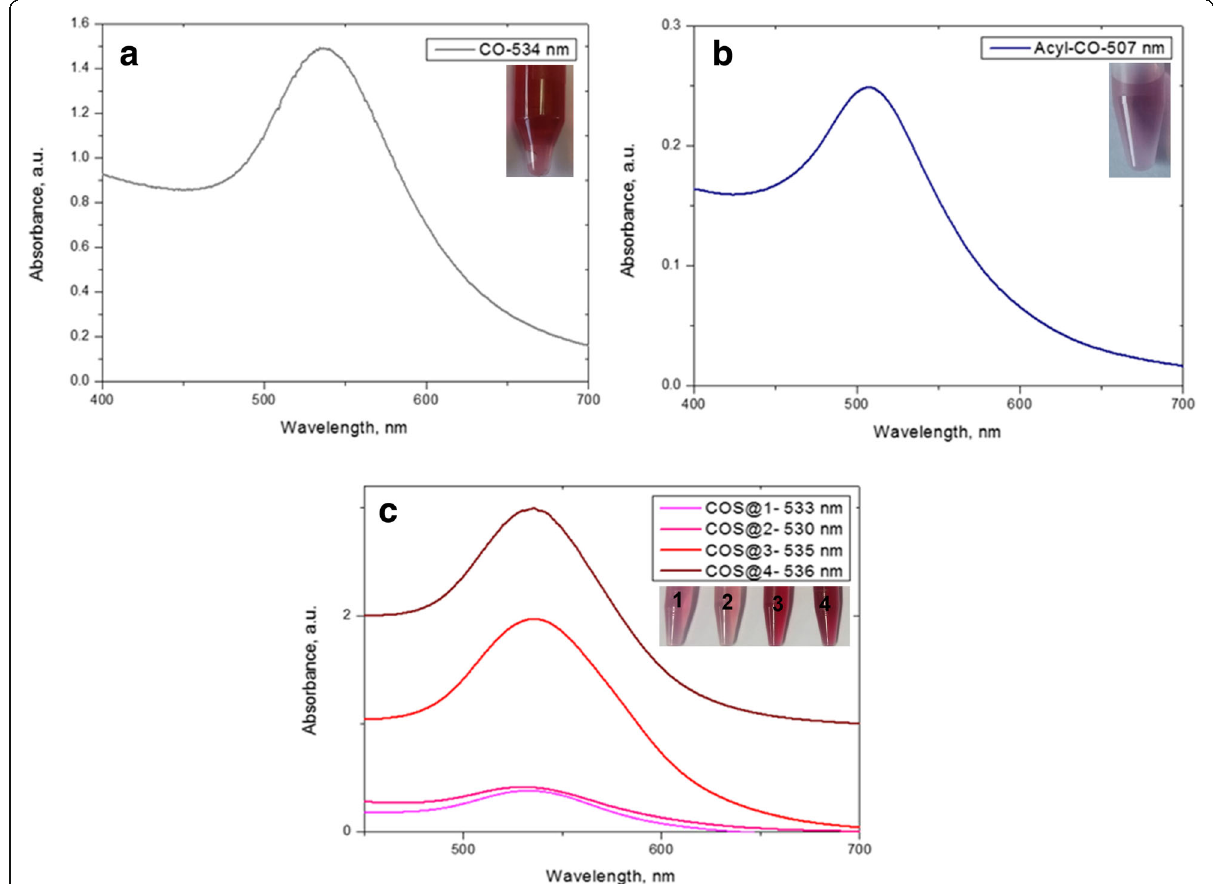
Fig. 3 UV-Vis spectra for nanocomposites. Values in the insets correspond to the maximum wavelength of the localized surface plasmon resonance. These maxima were as follows: for CO-AuNPs at 534nm (0.1M NaBH 4 ) ( a ), for Acyl-CO-AuNPs at 507nm ( b ), and for COS-@n-AuNP chitosan oligosaccharide at 533, 530, 535, 536nm for each at 1 – 4 different thickness nanocomposite preparations ( c